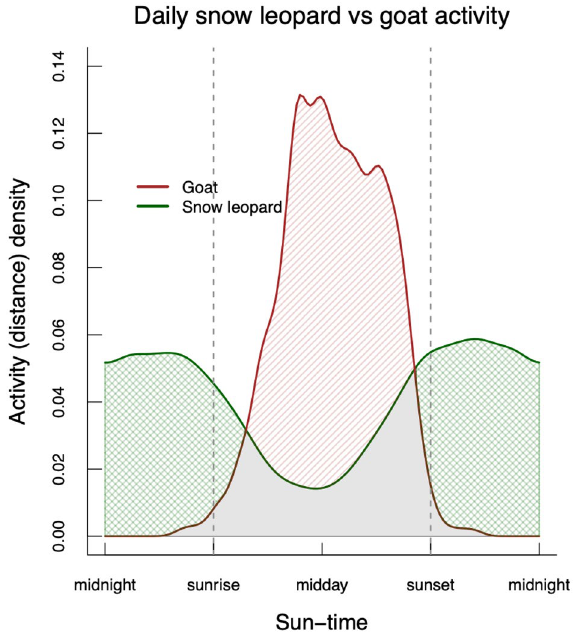
Figure 4. The relative proportion of activity across the 24-h cycle based on GPS movement data for adult snow leopards (green) versus domestic goats (brown). The activity density values have no absolute meaning, but rather are relative measures of probability density calculated from the raw movement data. The time of all observations has been standardised along the x-axis using ‘sun-times’; where the time of observation on each day is calibrated to sunrise, solar-noon (midday) and sunset. These overlap plots show the activity overlap (in grey) between snow leopards and goats: for periods when snow leopards use more of their activity budget relative to ibex this is shaded (cross-hatched) green, for periods when goats use more of their activity budget relative to snow leopards is shaded